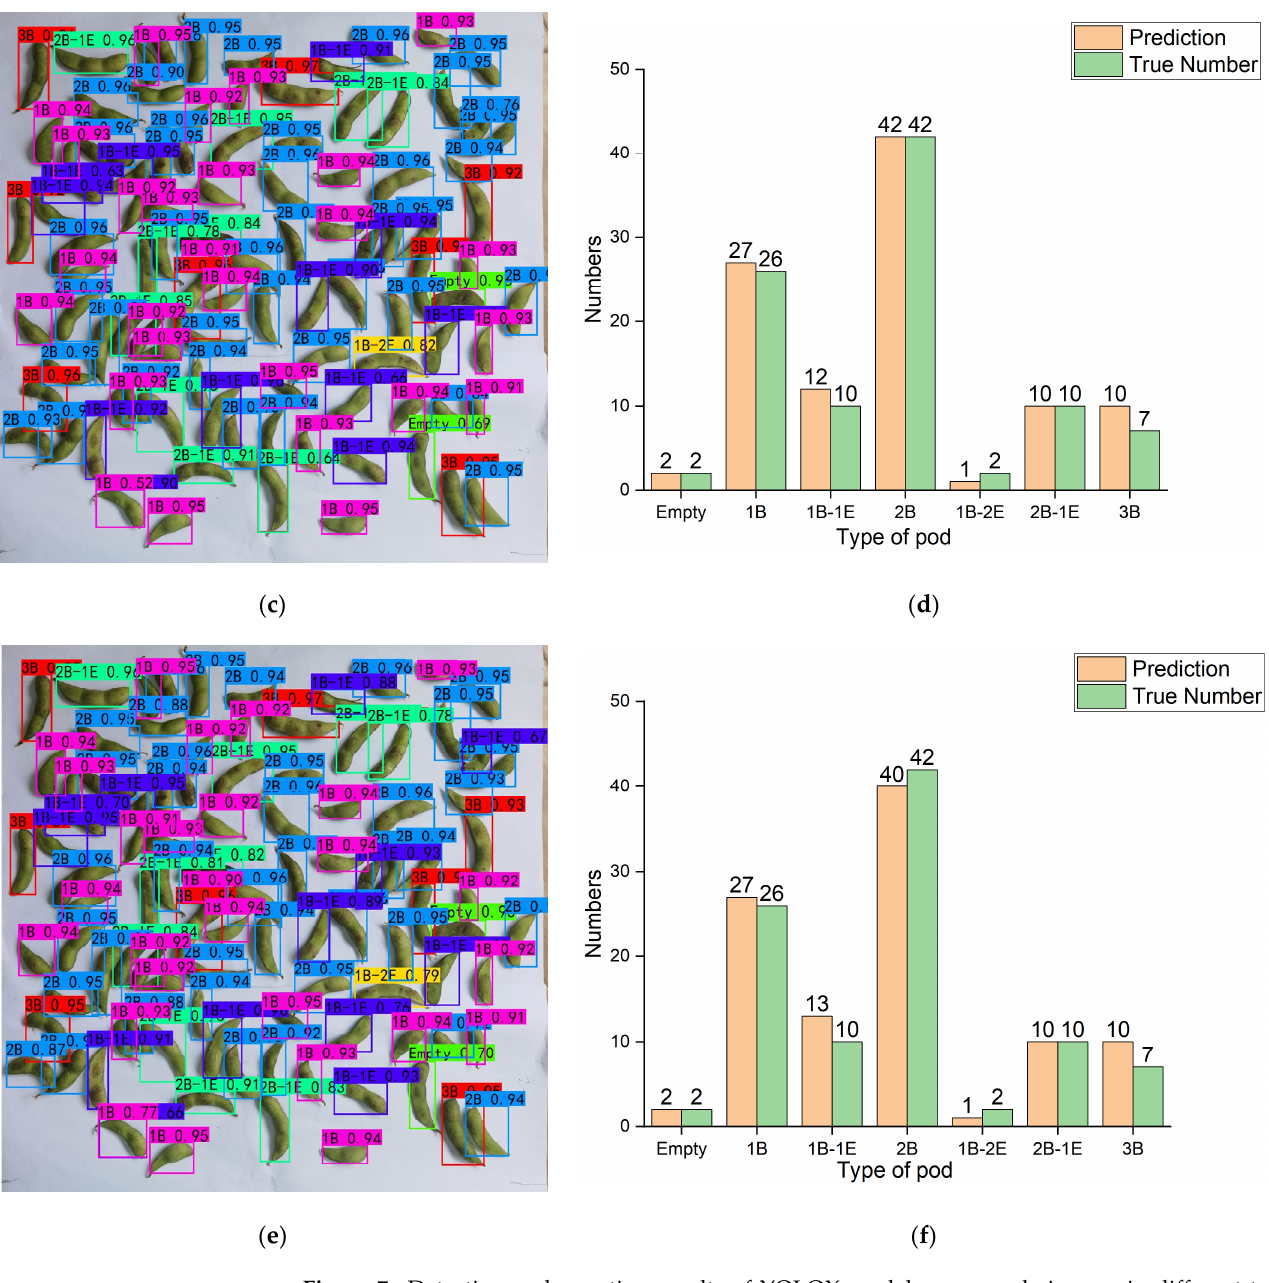
Figure 7. Detection and counting results of YOLOX model on example images in different test datasets. Different colored boxes are used to represent the detection results of different classes of pods. ( a ) Detection results of YOLOX on the test dataset CPD, ( b ) Count results of YOLOX on the test dataset CPD, ( c ) Detection results of YOLOX on the test dataset HPD, ( d ) Count results of YOLOX on the test dataset HPD, ( e ) Detection results of YOLOX on the test dataset LPD, ( f ) Count results of YOLOX on the test dataset LPD.